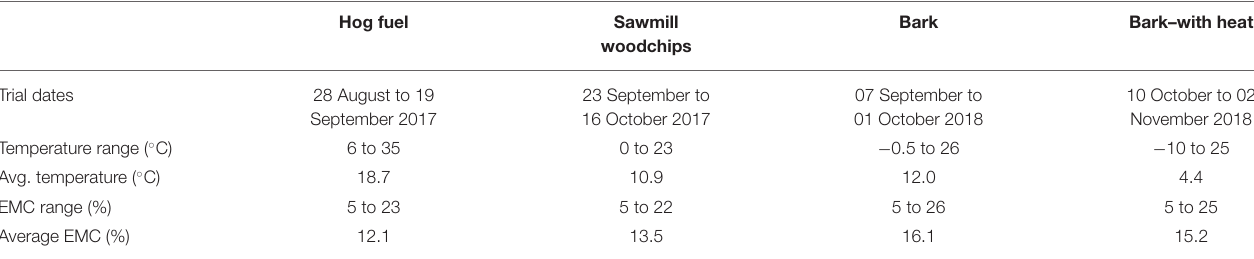
TABLE 5 | Ambient air temperature, equilibrium moisture content (EMC), and drying potential at various time periods. Hog fuel Sawmill Bark Bark–with woodchips